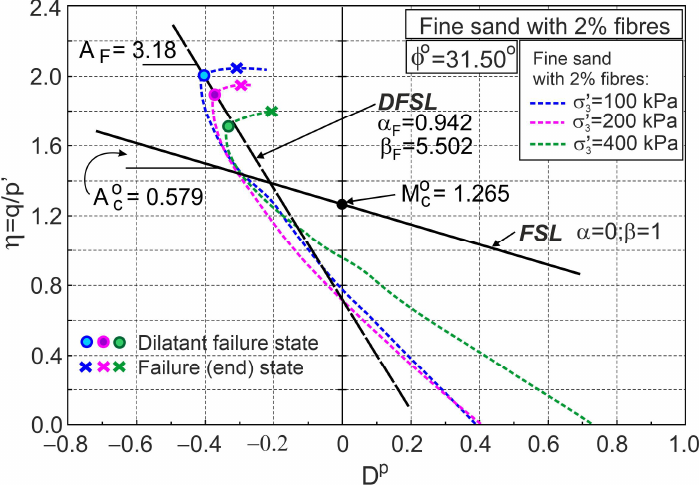
Figure 7. Stress ratio–plastic dilatancy relationships for sand with 2% fibres (based on the experi- mental data from [5]).